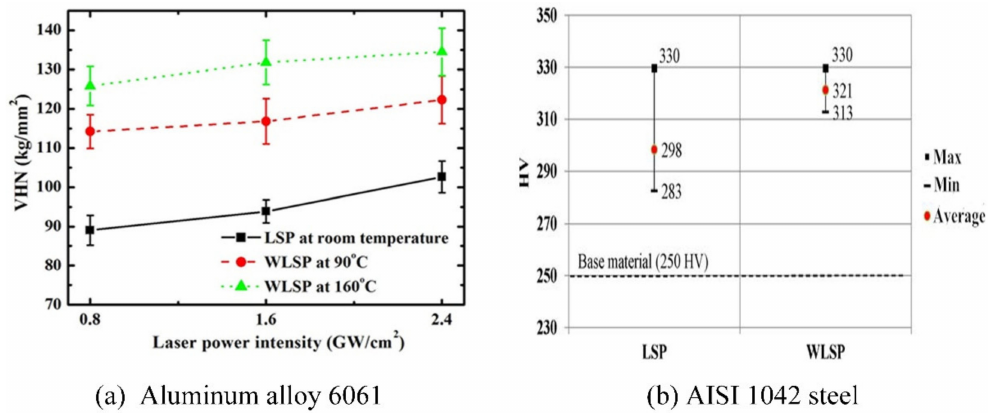
Figure 10. The enhanced surface hardness by WLSP: ( a ) aluminum alloy 6061, ( b ) AISI 1042 steel